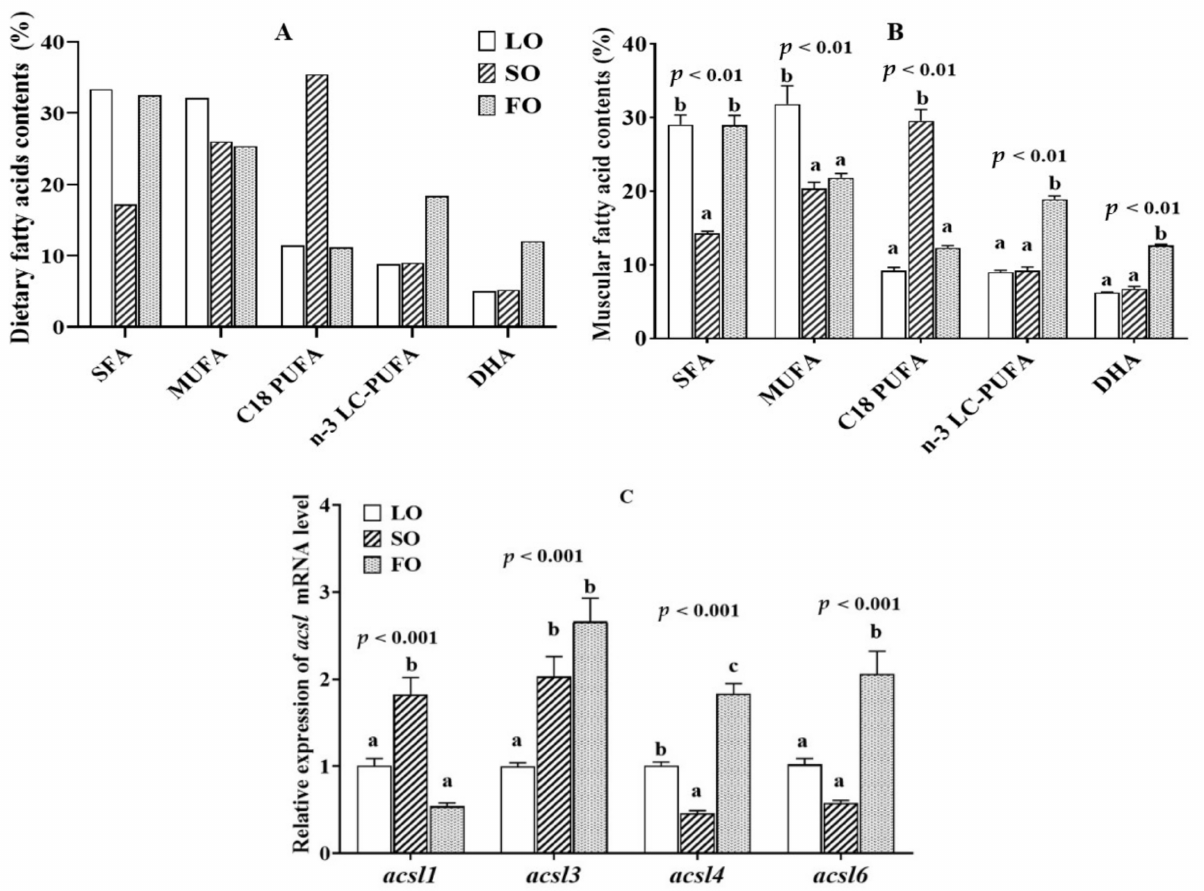
Figure 3. Muscular fatty acid contents ( B ), and acsl family mRNA relative level ( C ) of juvenile Trachinotus ovatus fed diets with different lipid sources ( A ). Values are means ± SEM from three treatments of fish ( n = 3) with three fish per cage, and bars not sharing a common letter indicated significant differences ( p < 0.05) among deletions determined by one-way ANOVA followed by Tukey’s multiple